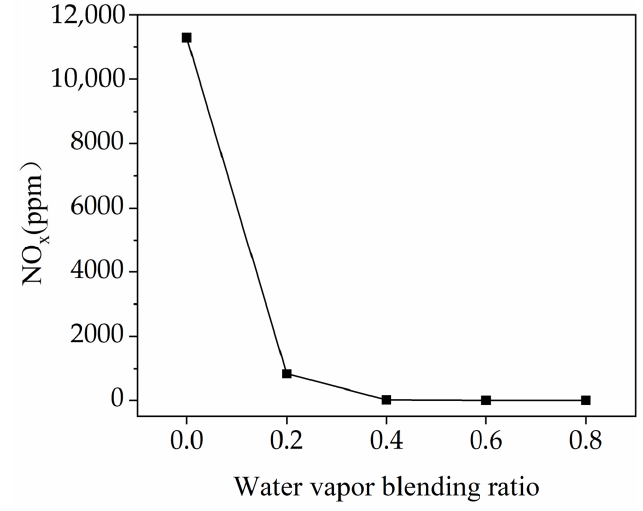
Figure 13. Variation curves of NO x mole fraction under different α .